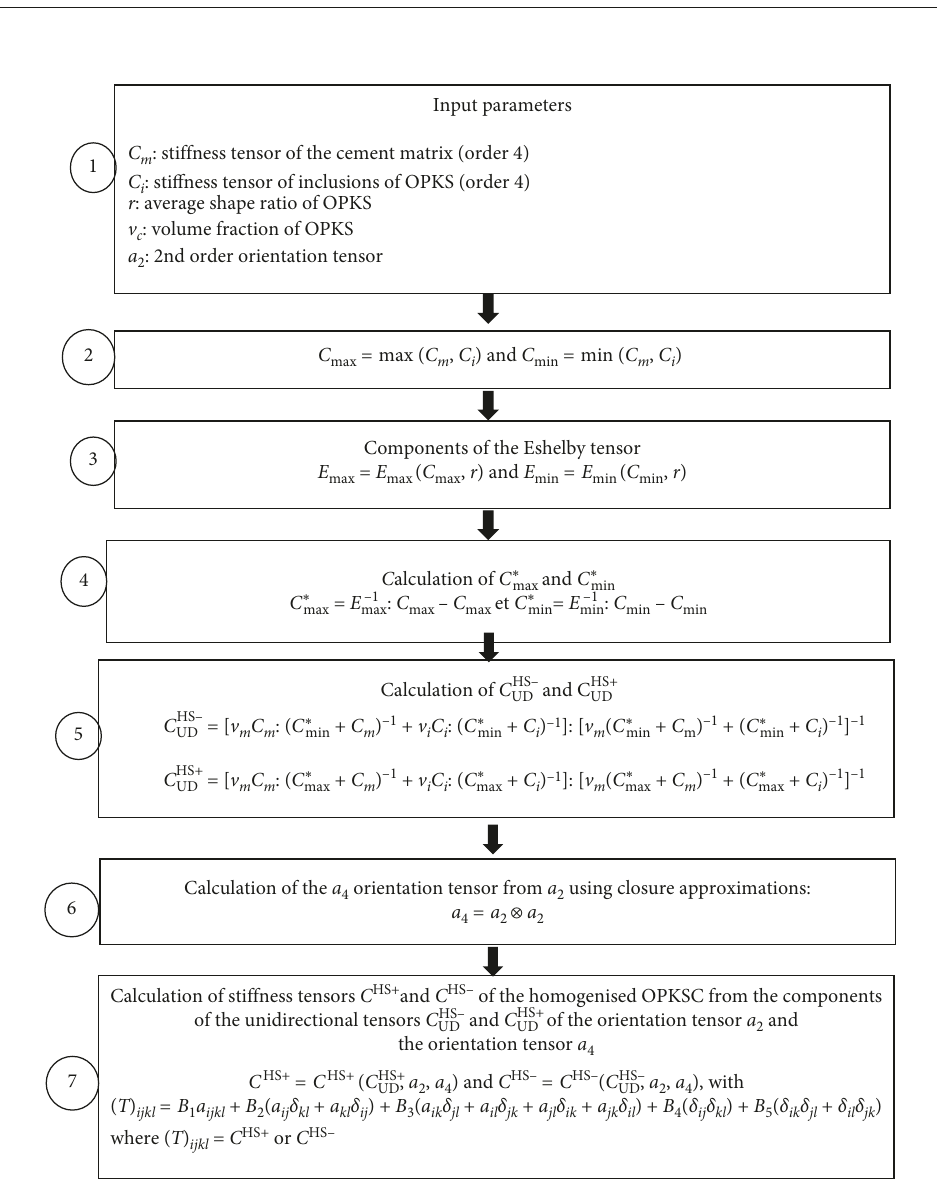
Figure 8: Determination of homogenised stiffness tensor (HS